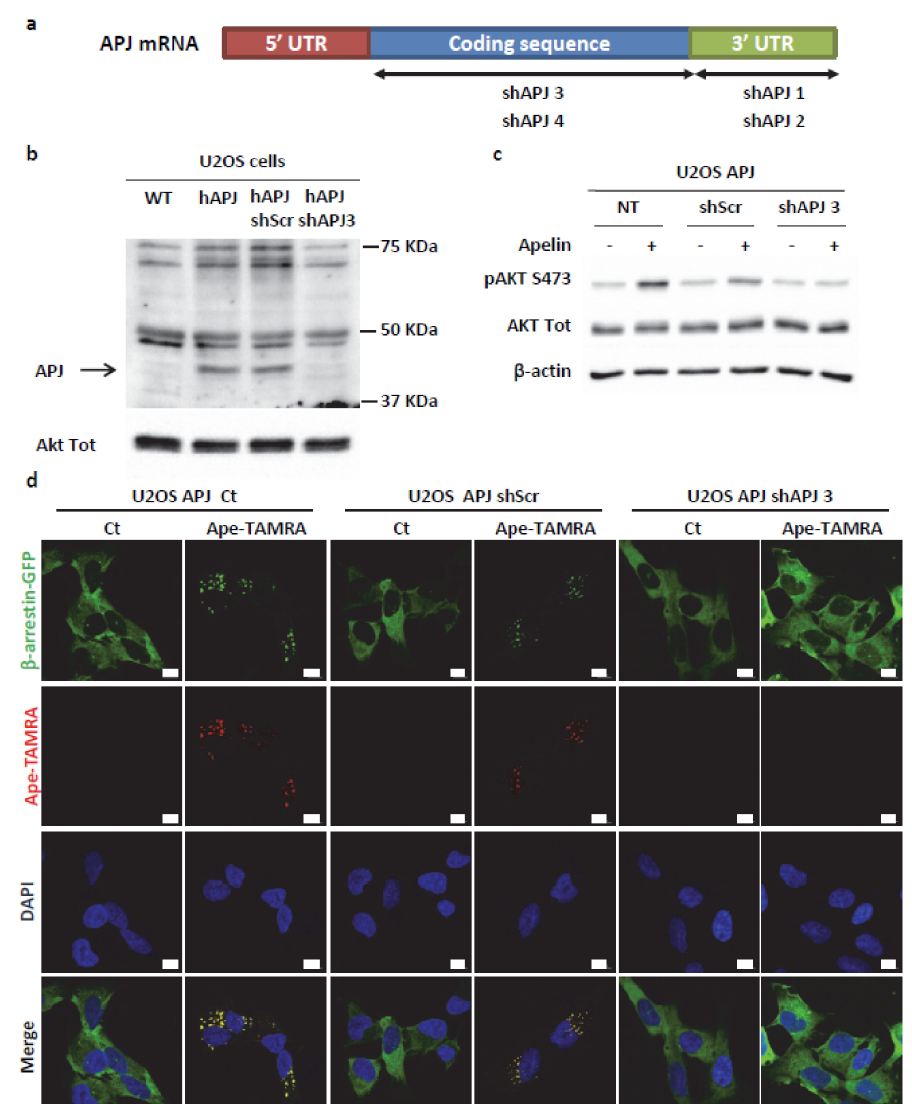
Figure A6. Validation of shRNA against APJ in U2OS cells stably expressing hAPJ. ( a ) Schematic representation of the 4 different shRNA position-targeting human apelin receptor mRNA. ShAPJ1 and shAPJ2 target the 3’UTR, whereas shAPJ3 and shAPJ4 target the coding sequence of hAPJ mRNA. ( b ) Lysates from wild-type U2OS cells; U2OS cells stably expressing hAPJ; U2OS cells stably expressing hAPJ and Scramble shRNA (shScr); and U2OS cells stably expressing hAPJ and APJ shRNA 3 (shAPJ 3) were probed using the anti-APJ antibody. Total Akt was used as a gel-loading control. Representative Western blots from n = 2. ( c ) Apelin activity on U2OS cells expressing hAPJ is fully abrogated when APJ shRNA 3 is expressed compared to wild-type cells (NT, nontransfected) and U2OS cells expressing both hAPJ and scramble shRNA. Cells were serum-starved for 20 h and then stimulated with apelin (0.5 µ M) for 30 min. Western blot analysis of phospho-Ser473-Akt, phospho-Thr308-Akt, total Akt and β -actin are presented. Representative Western blots from n = 2. ( d ) Confocal pictures of U2OS cells stably expressing hAPJ, β -arrestin 2-GFP with or without shRNA Scramble (shScr) or APJ shRNA 3 (shAPJ 3) and stimulated with PBS (Ct) or with fluorescent apelin- TAMRA (10 nM) for 1 h. Apelin treatment induces internalization of hAPJ/ β -arrestin 2-GFP in complex with apelin-TAMRA except in U2OS cells expressing shAPJ 3. Red channel illustrates the localization of apelin-TAMRA, whereas green channel shows β -arrestin 2-GFP. Scale bar, 10 µ